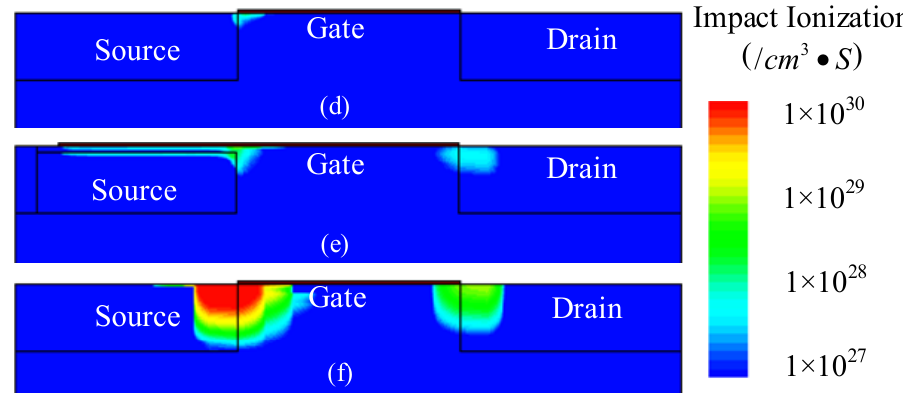
Figure 4. Band-to-band tunneling generation rates of ( a ) point TFET, ( b ) line TFET and ( c ) Ge-source TFET, and impact ionization rates of ( d ) point TFET, ( e ) line TFET and ( f ) Ge-source TFET at a voltage pulse of 3 V.